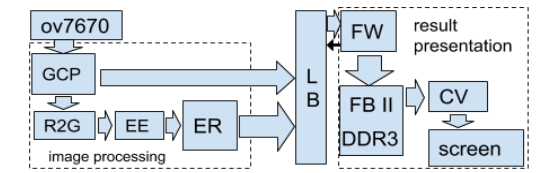
Fig. 1. Block diagram of the hardware implementation.